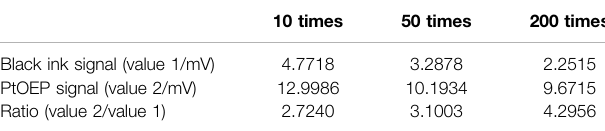
TABLE 2 | TTD image signal value (0 µs time delay) with different signal averages. 10 times 50 times 200 times Black ink signal (value